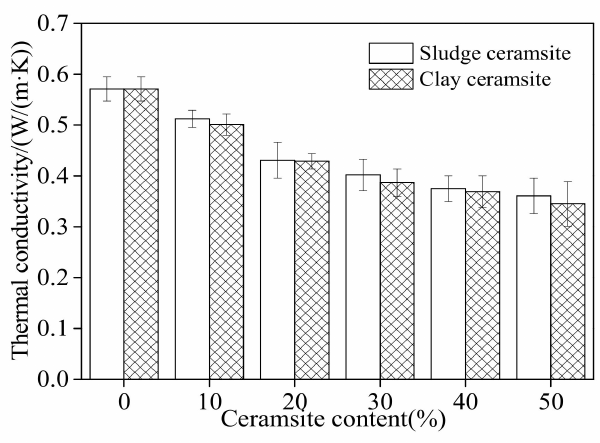
Figure 9. Thermal conductivity of